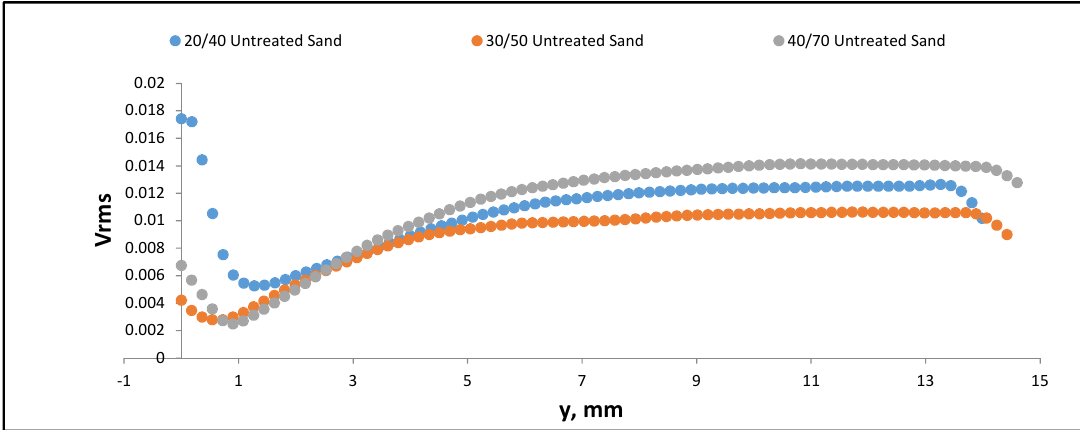
Figure 10. The radial turbulence intensity profile for the flow of polymer fluid over the untreated sand bed at the subcritical velocity of 0.25 m/s.